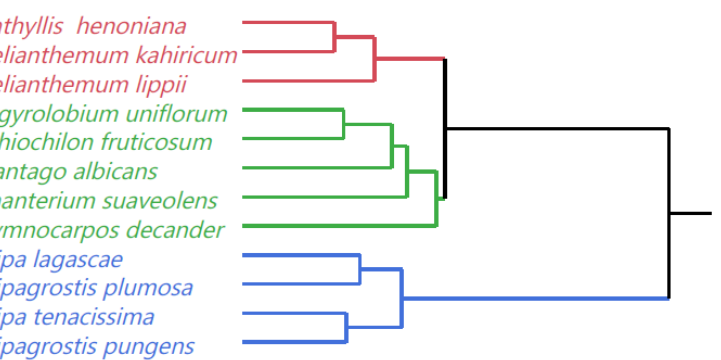
Figure 7. Dendrogram for twelve native perennial species from arid rangelands of southern Tunisia by average linkage method based on forage biomass yield, plant measurements and determinants of forage quality. Different colors represent different clusters (red: Cluster 1 color, green: Cluster 2: color, blue: Cluster 3).